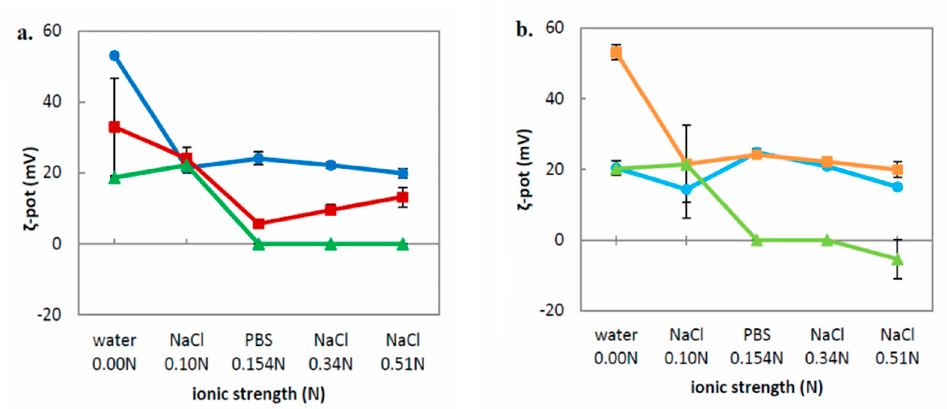
Figure 4. ζ -potential ( ζ - pot, mV) of a. GMO nanosystems and b. PHYT nanosystems diluted in five